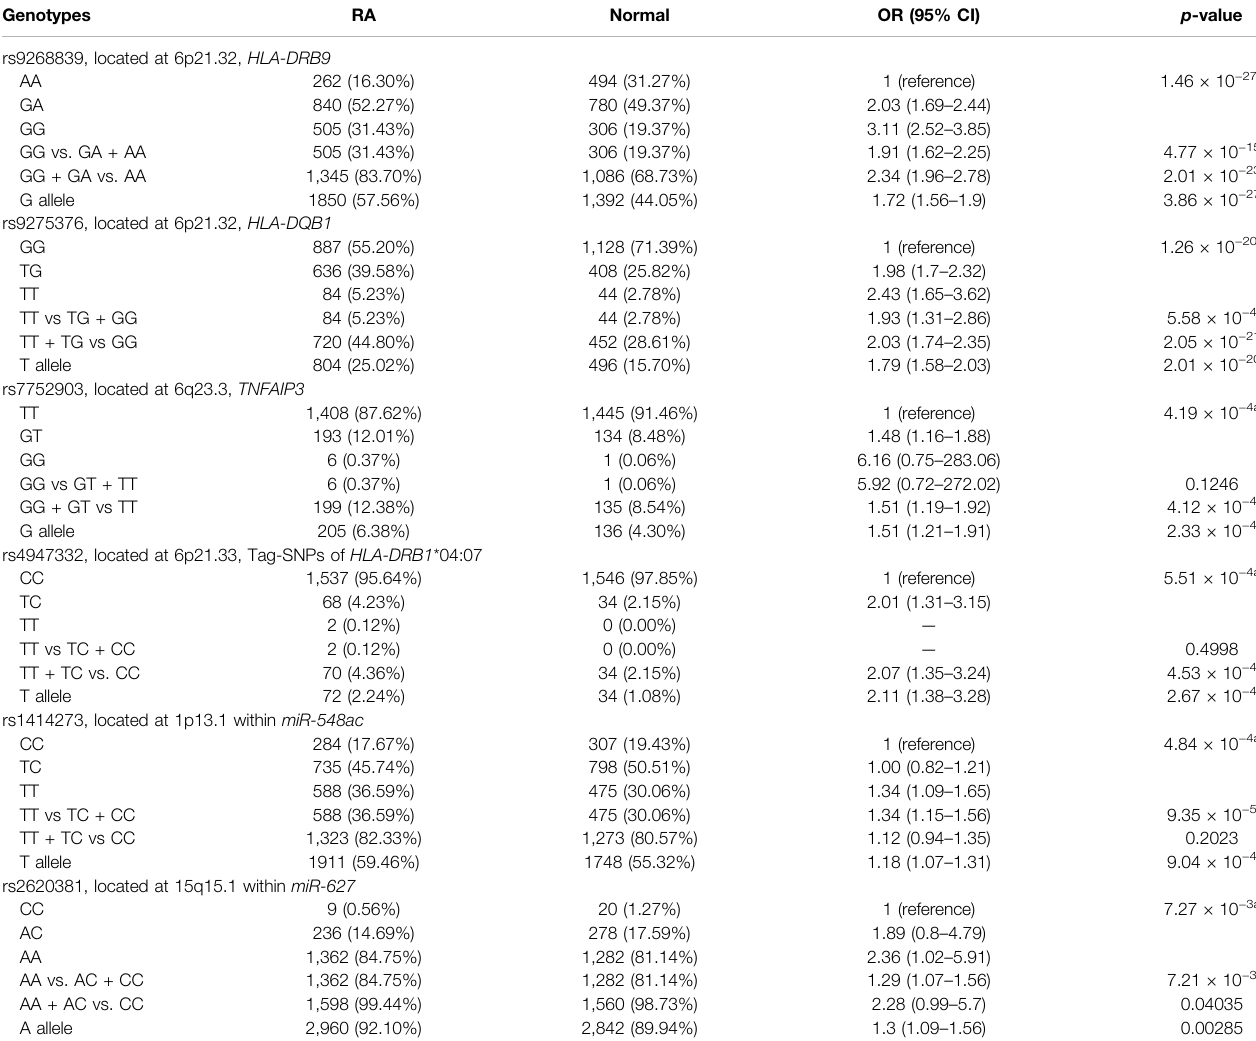
TABLE 2 | Association statistics for rheumatoid arthritis susceptibility and genetic variants. Genotypes